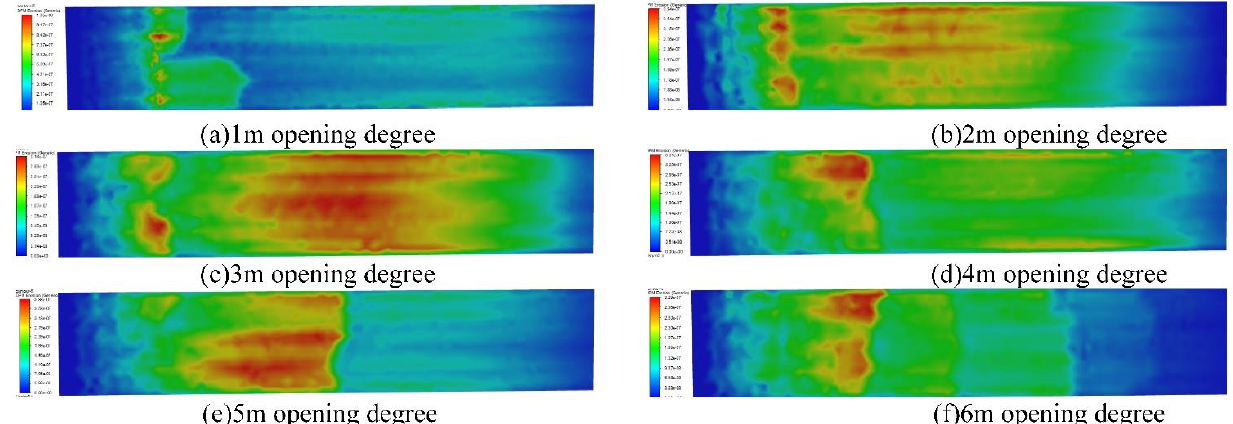
Figure 14. Erosion cloud diagram of spillway with different gate openings.